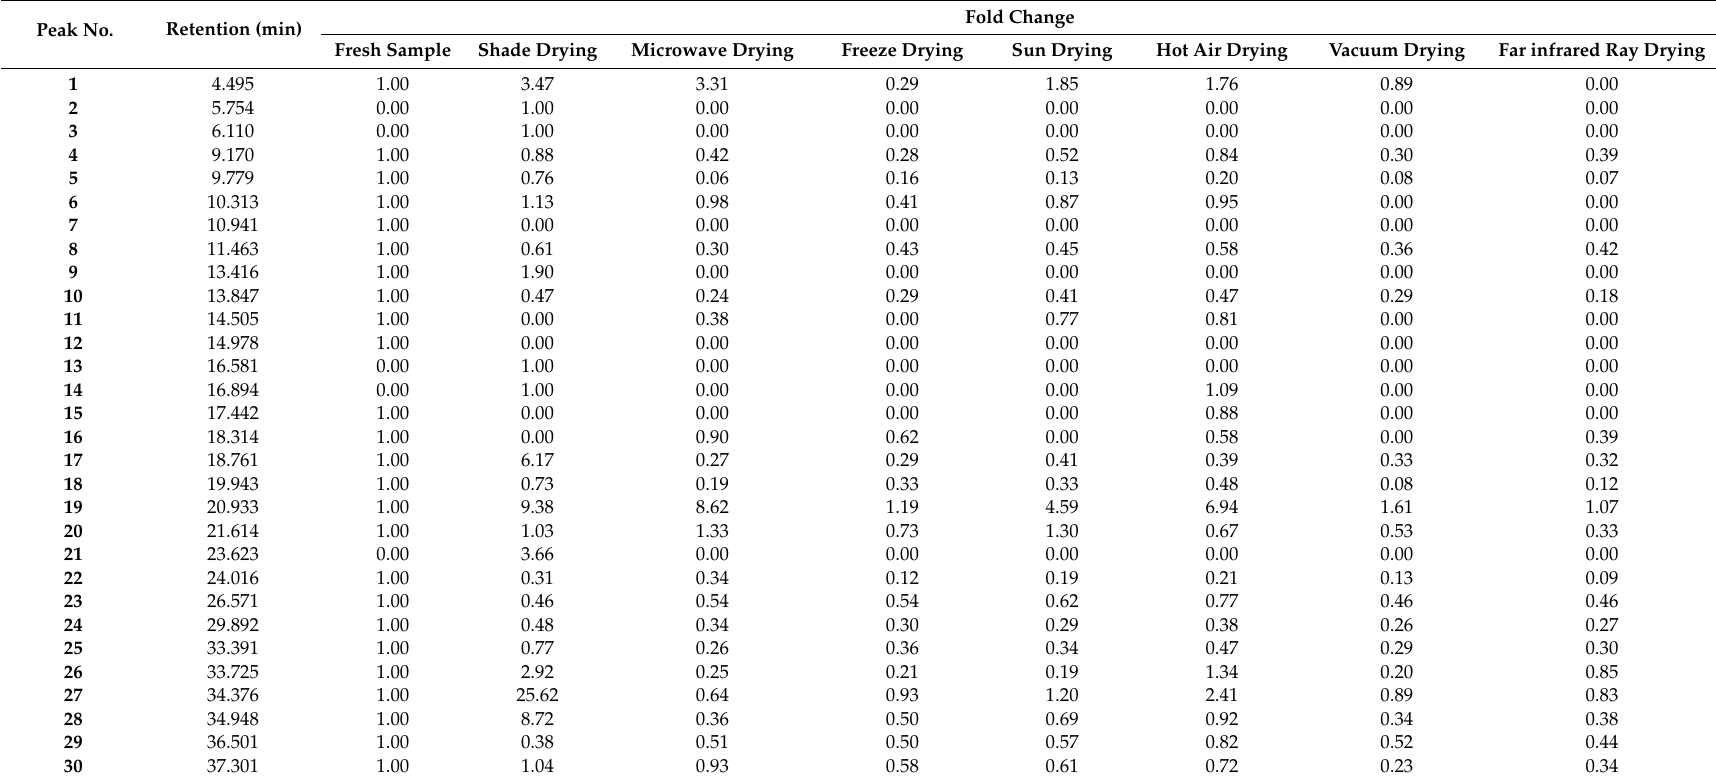
Table 4. Relative fold change of the main compounds in eight